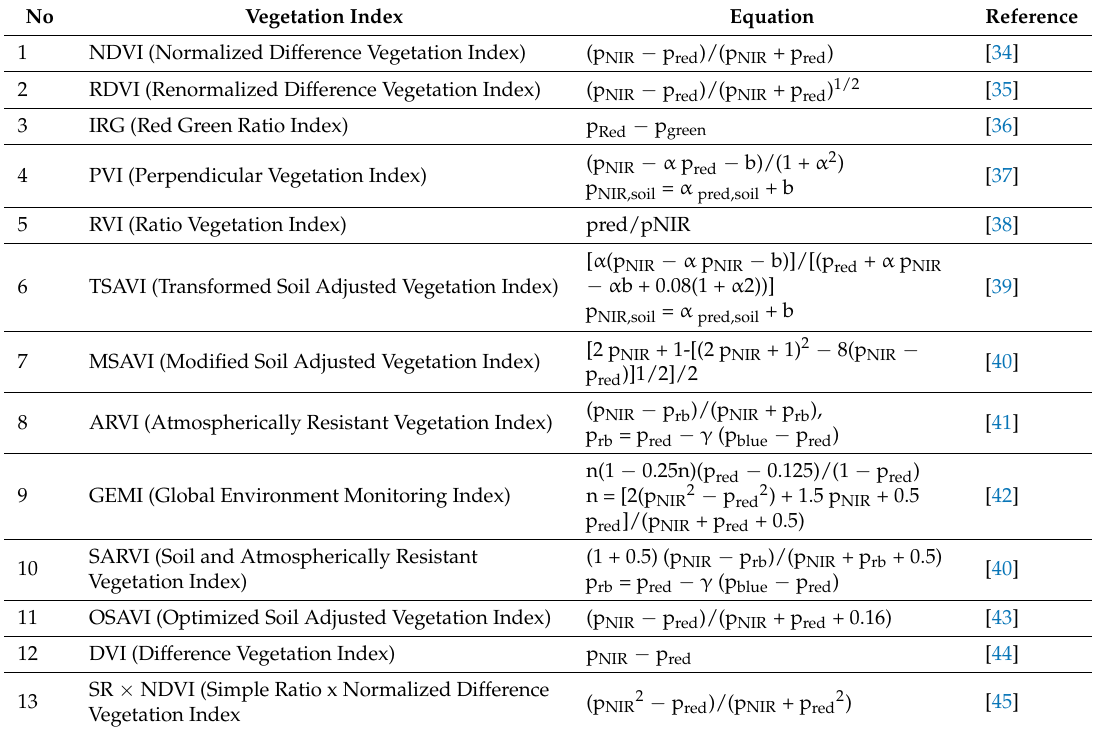
Table 1. Multispectral vegetation indices used in the